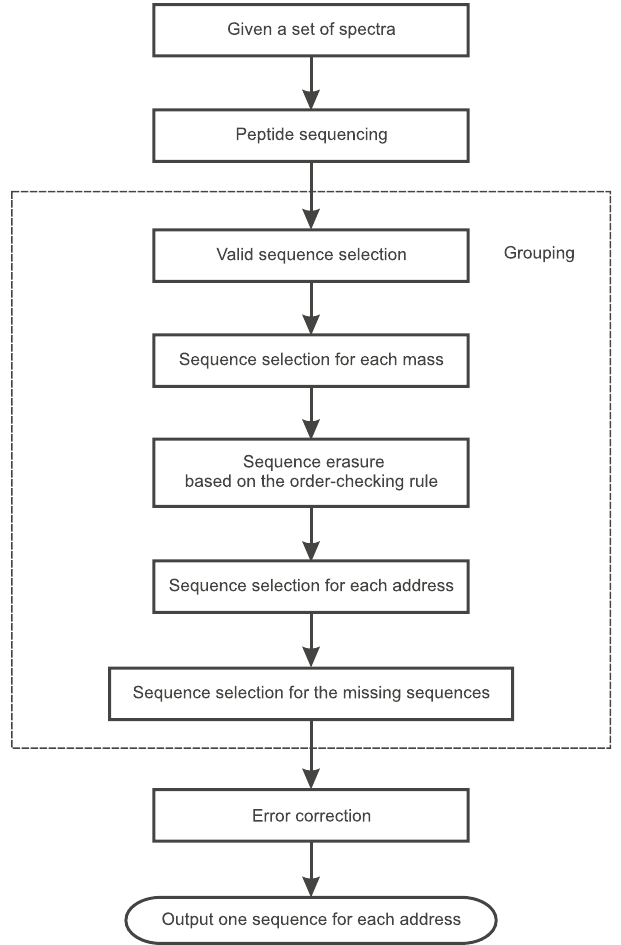
Fig. 6 A fl owchart illustrating the method of sequence grouping. The procedure of grouping is shown in the dashed